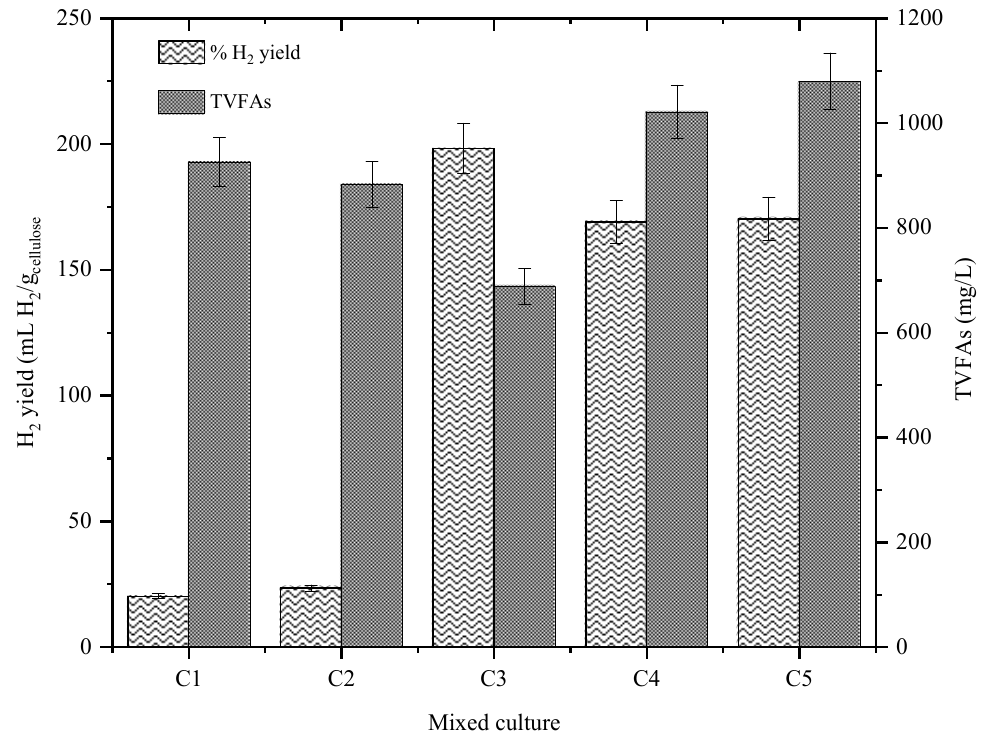
Figure 1. Hydrogen yield from alpha-cellulose by enriched mixed cultures from elephant dung in each repetitive sub-culture for five generations (Cycle (C) 1–Cycle (C) 5).